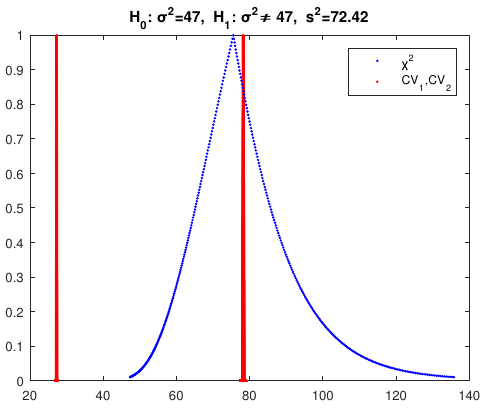
Figure 12. The possibility distribution of the fuzzy statistic (cid:101) χ 2 for the test of Example 4 for a sample with variance s 2 =